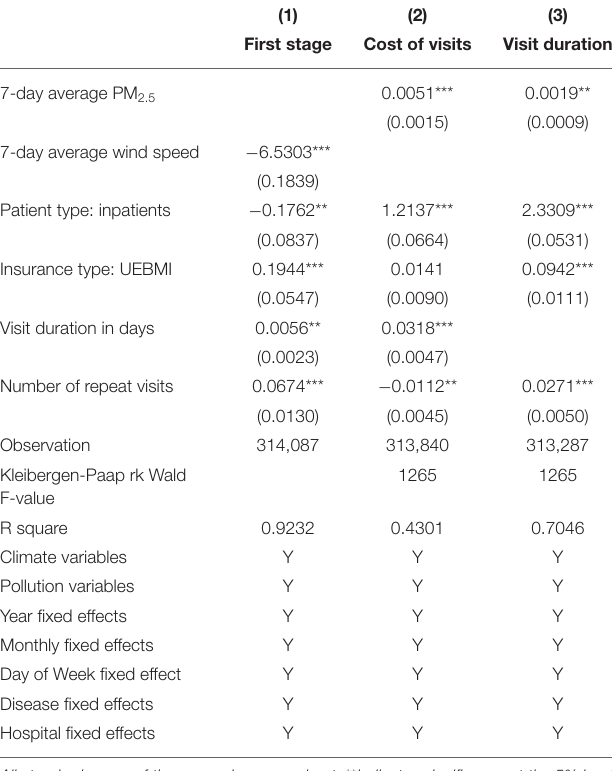
TABLE 4 | Impact of air pollution to circulatory disease patients with alternative IV.